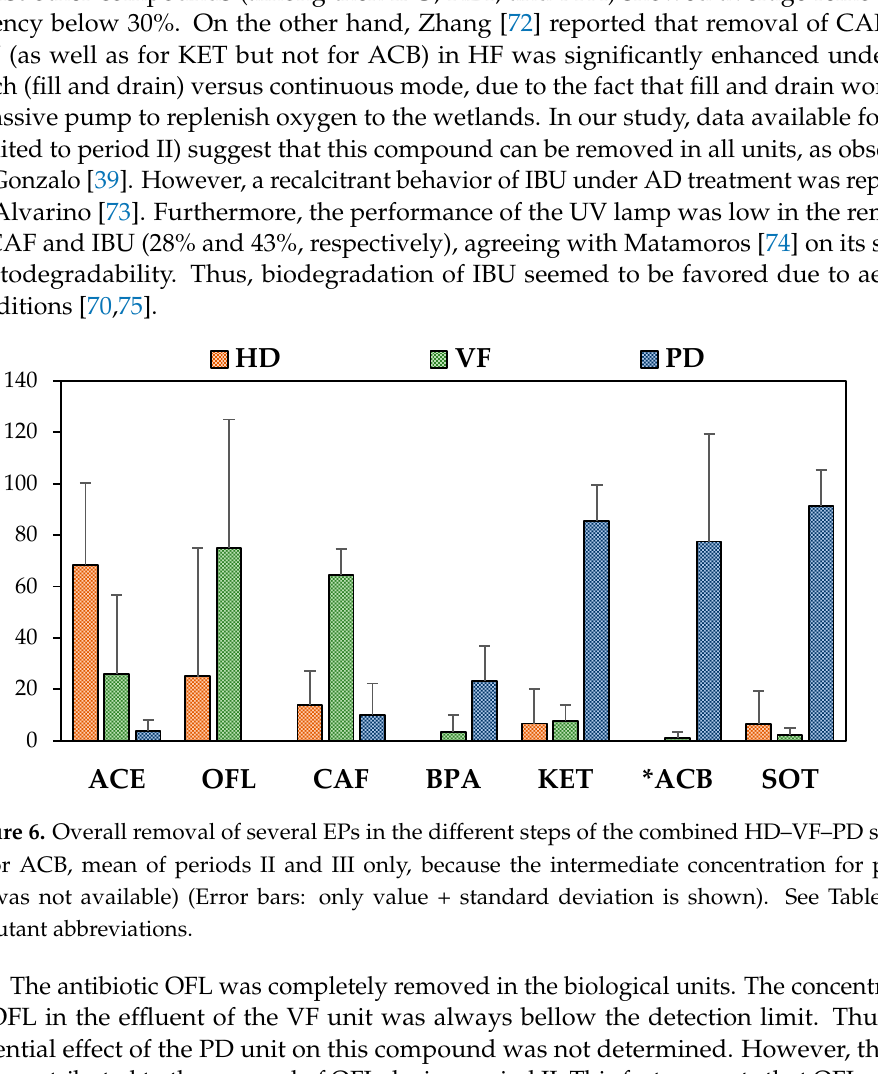
Table 6. Results for PD cell treating raw MW and HD–VF effluent